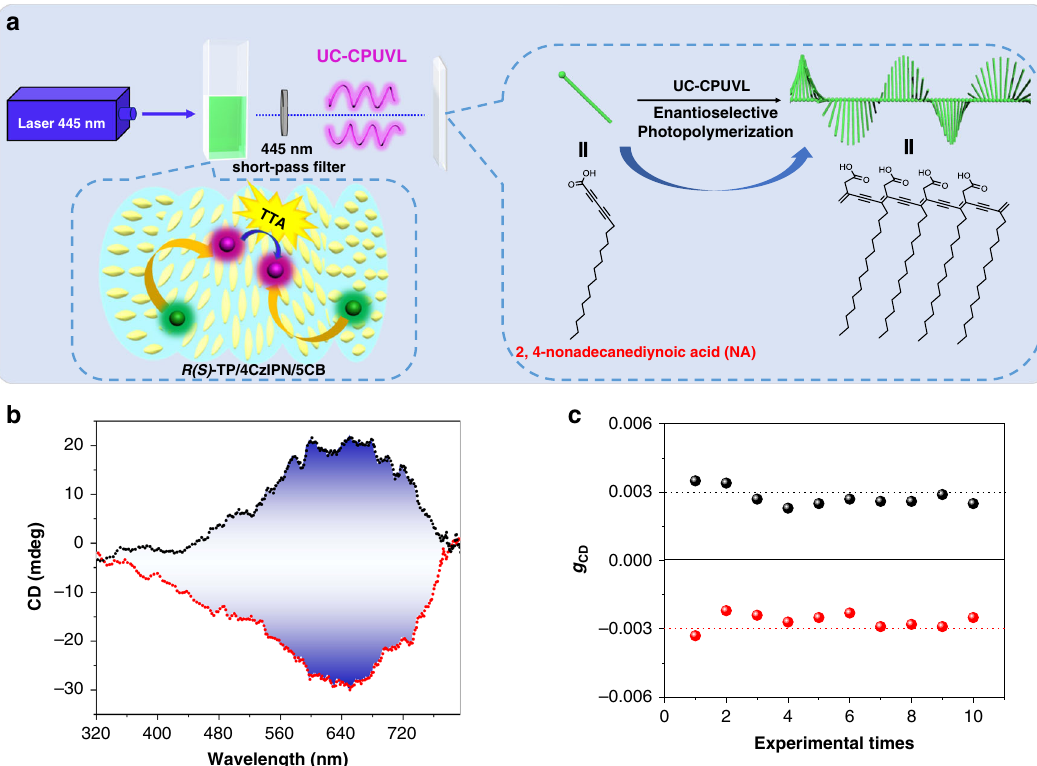
Fig. 6 UC-CPUVL triggered enantioselective photopolymerization. a Schematic setup of the enantioselective photopolymerization of NA. All of them were kept in the dark. A 445 nm CW semiconductor laser was used as light source. The complexes of R- TP / 4CzIPN/5CB ([ R- TP] / [4CzIPN] = 30/1, R -TP/ 5CB is 10 wt%) were sealed in a quartz cell (0.1 cm optical length) re fi lled with argon. The quartz plate covered with 2, 4-nonadecanediynoic acid spin- coating fi lm was placed behind the sample, with a 445 nm short-pass fi lter placing between them. b CD spectra of PDA fi lms after exposing to the UC- CPUVL generated from the excited R- TP / 4CzIPN (black dash line) and S- TP / 4CzIPN (red dash line) in N*LC with incident excitation of the 445 nm CW laser (A 445 nm short-pass was used). c Absorption dissymmetry factor g CD (640 nm) of the obtained chiral PDA in 10 different batches. The black spheres represented the g CD of PDA after exposing to the UC-CPUVL generated from the excited R -TP/4CzIPN/5CB and the red spheres represented the g CD of PDA after exposing to the UC-CPUVL generated from the excited S -TP/4CzIPN/5CB, upon excitation with 445nm CW laser. At least three irradiation experiments were performed to obtain the average CD